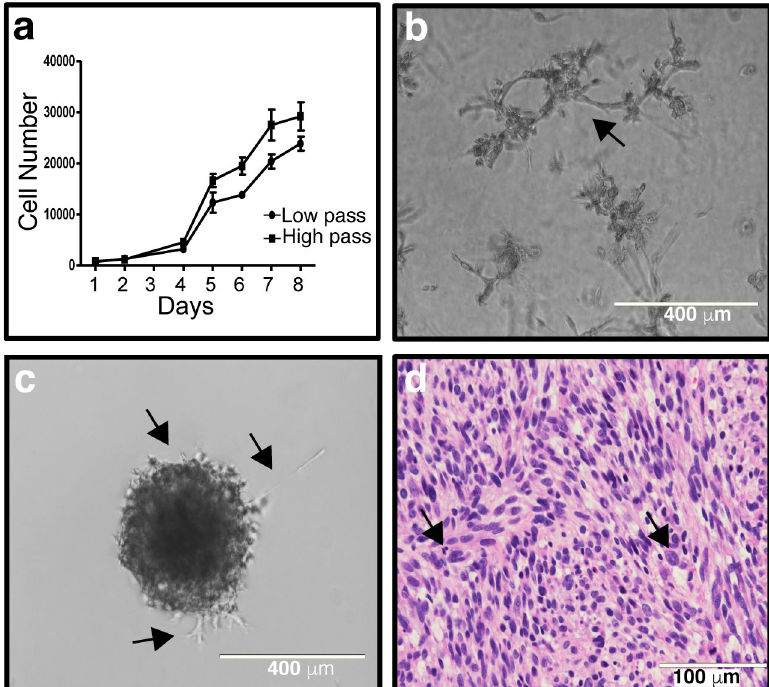
Figure 5. Growth characteristics of 2XSB MPNST cells in 2D cultures, 3D cultures, clonogenic assays and xenografts. ( a ) In vitro doubling time of both low (P6) and high passage (P54) cultures shows a consistent rate of proliferation in these passages. ( b ) Representative image of a 3D culture of 2XSB cells grown for 1-week post- plating on Matrigel demonstrating the high degree of invasive projections into Matrigel characteristic of this line (arrow). ( c ) Representative image of a clonogenic round bottom spheroid assay 1-week post-plating showing that 2XSB cells have the ability to survive and proliferate when embedded in Matrigel, resulting in the formation of colonies. These colonies also showed multiple regions of tumor cells invading the Matrigel (arrows). ( d ) A ×40 image of a hematoxylin and eosin stained section of a xenograft derived from 2XSB cells showing that the xenograft has histologic features resembling those of the parent tumor. Arrows indicate some of the numerous mitotic figures present in this